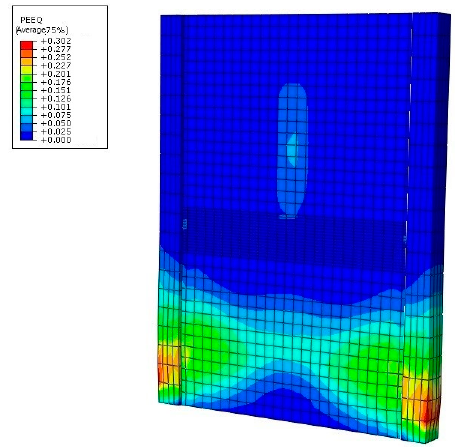
Figure 15. PEEQ of concrete for SPRC-2